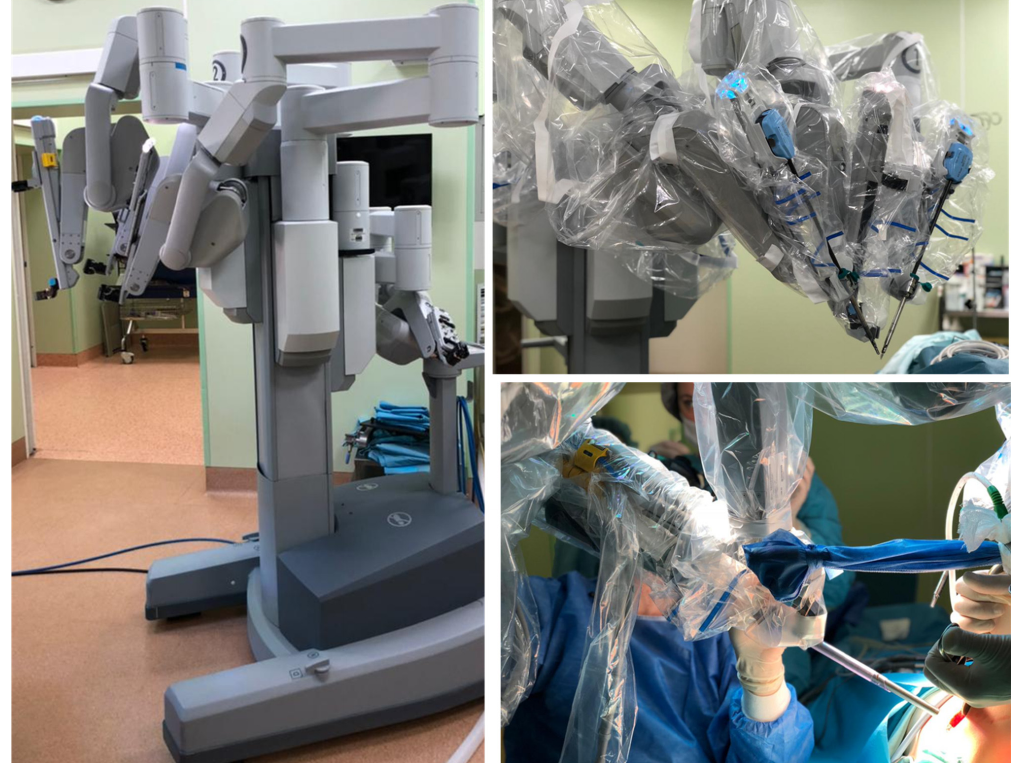
Figure 1. Schematic depiction of robot-assisted surgery (example: da Vinci robot-assisted surgical system) equipped with easily maneuverable, flexible, and stable mechanical arms. The implications of the robot-assisted surgery system can assist the surgeon to perform surgery typically with substantial precision and can generate patient-satisfied aesthetic requirements according to the design of incision. Model: the latest da Vinci’s robot-assisted surgery model is “the Si”, released in 2009. It is composed of a master console, a mobile platform, and an operational cart with four arms; Company: Intuitive Surgical Inc., Sunnyvale, CA, USA; Date of image acquisition from the I.M. Sechenov First Moscow State Medical University of the Ministry